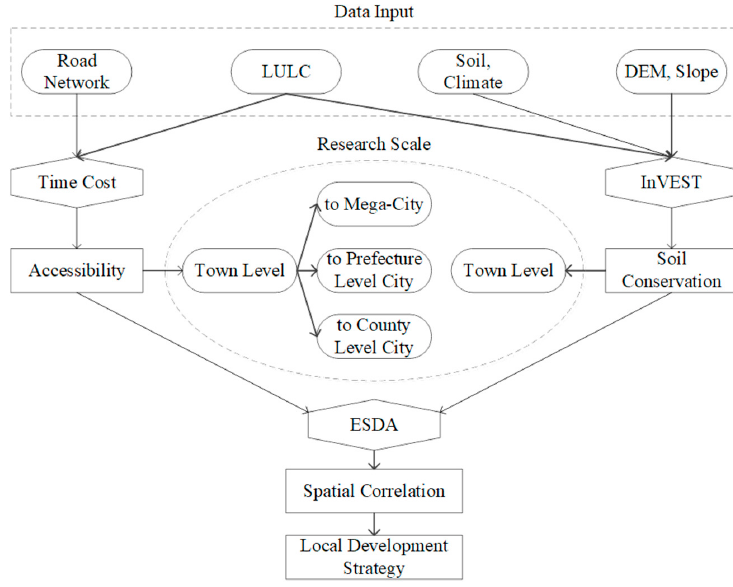
Figure 2. Research